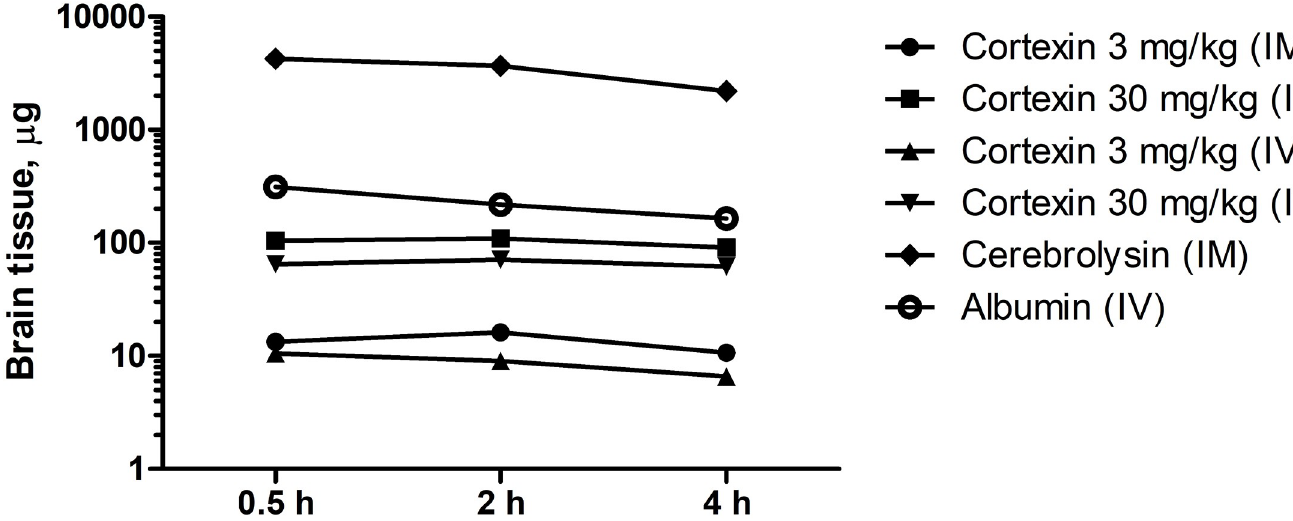
Fig 13. Brain content of 125 I-labeled Cortexin 1 , Cerebrolysin 1 and albumin in mice. Data shown as geometric mean (n = 15).